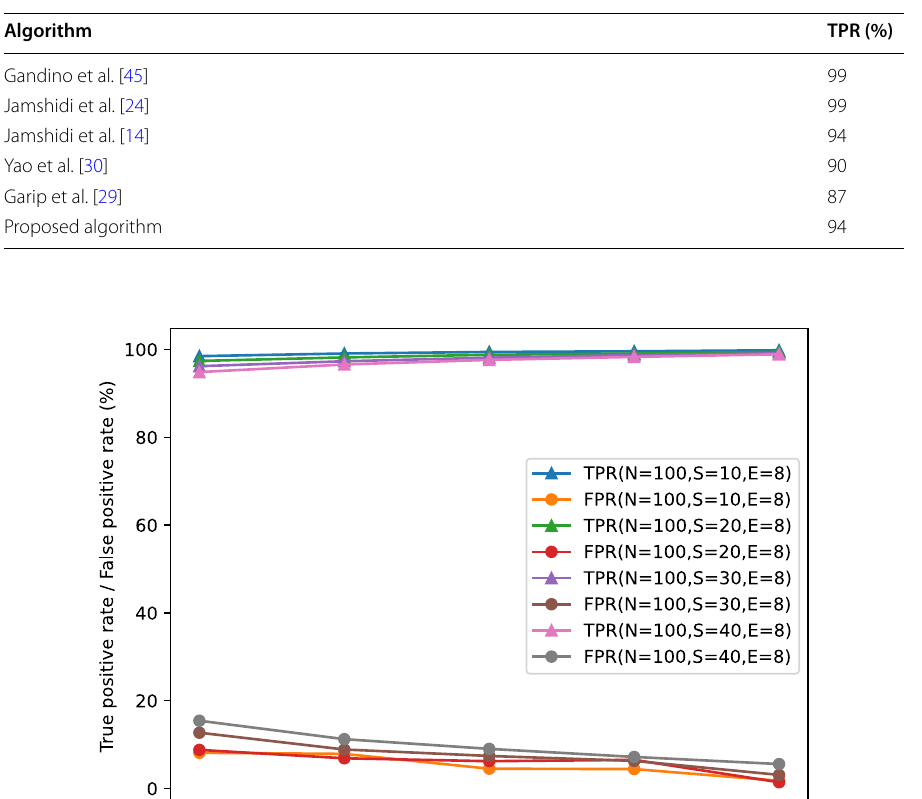
Table 3 Comparison of performance of the proposed algorithm and other latest algorithms in terms of TPR